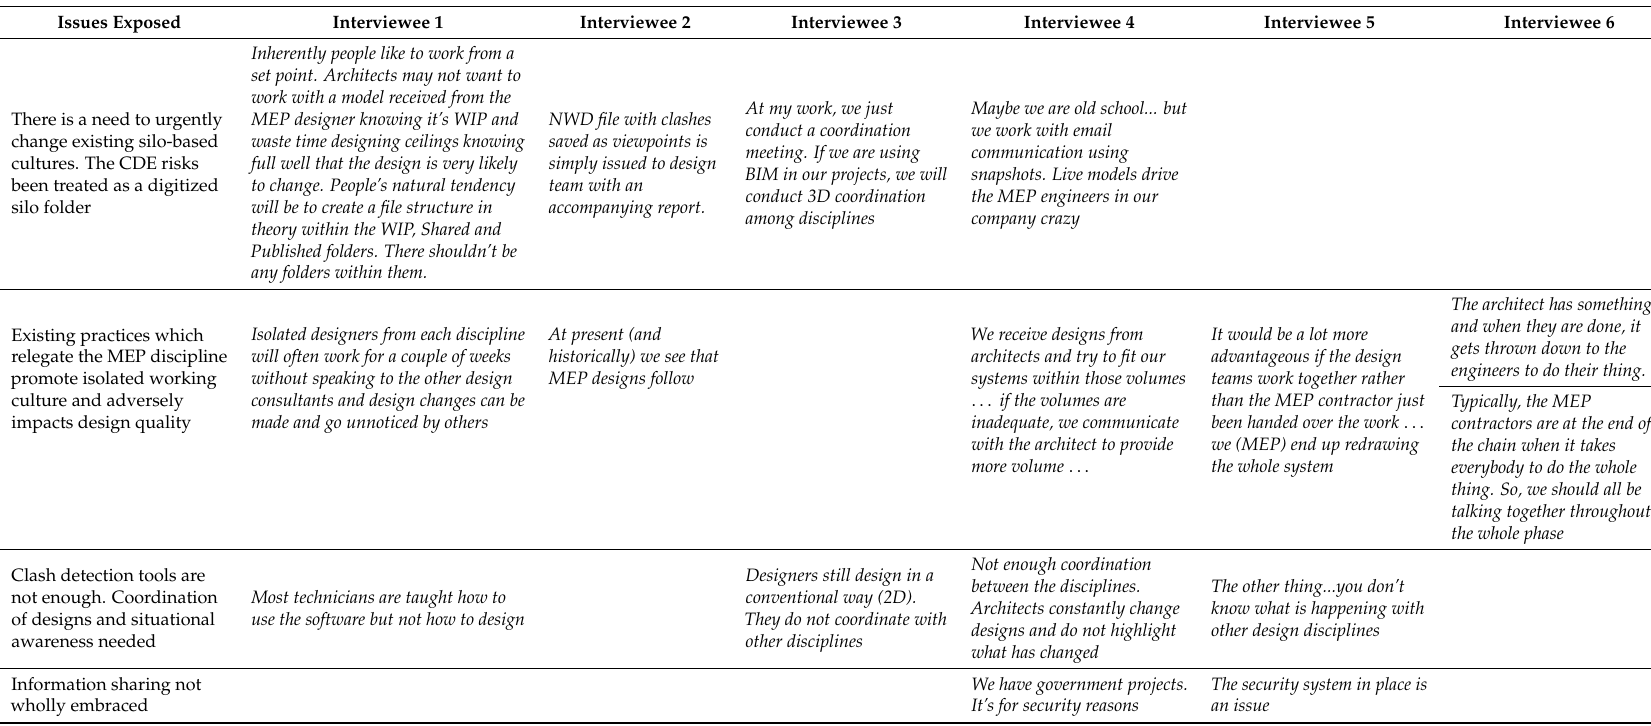
Table 9. Summary of key issues exposed in the qualitative research (interviewees’ comments in